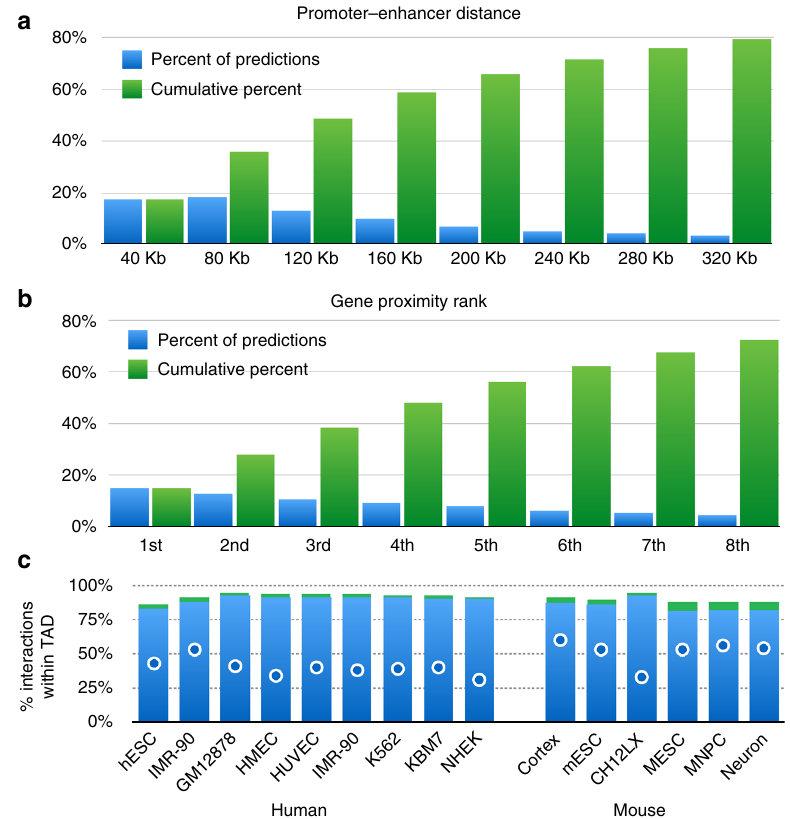
Fig. 4 Promoter – enhancers interactions. a . Distribution (blue) and cumulative distribution (green) of promoter – enhancer interactions for mouse cortex data 25 , as predicted form PSYCHIC (FDR < 1e-2). b Same as (A), reporting the proximity rank of genes associated with predicted enhancer bins. c Most putative enhancers reside within the same TAD as their targets. For each of the 15 human and mouse Hi-C experiments analyzed, the Y -axis shows the percent of predicted DNA – DNA pairs to fall within the same topological domain. Green supplements show the percent of additional pairs falling within 1st level of TAD – TAD hierarchical merges. Blue dots show percent of “ random ” enhancers residing within the same